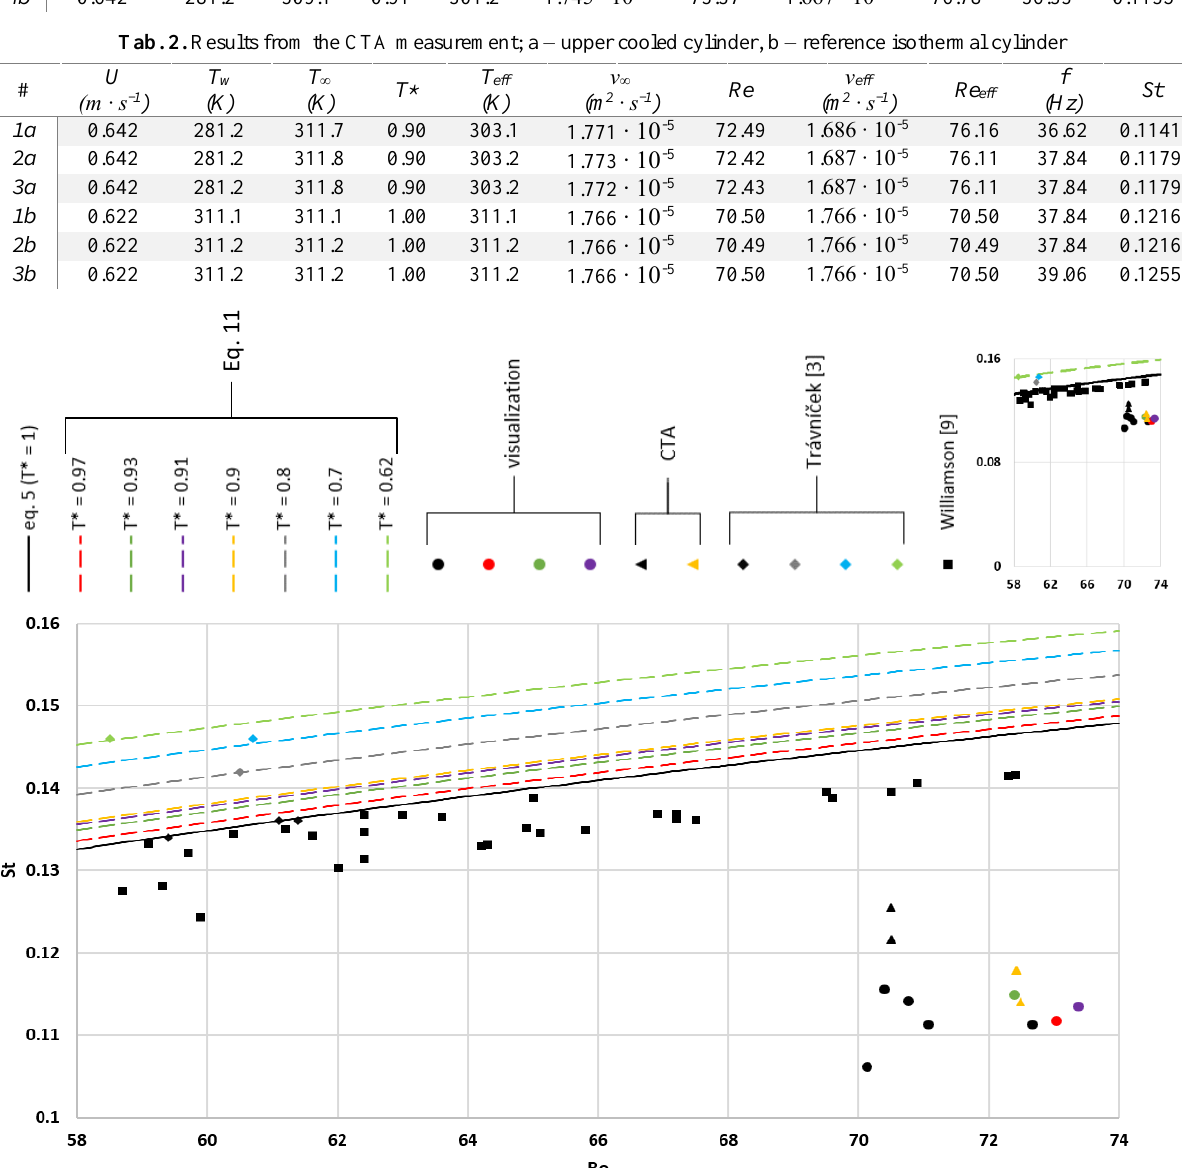
Tab. 2. Results from the CTA measurement; a – upper cooled cylinder, b – reference isothermal cylinder